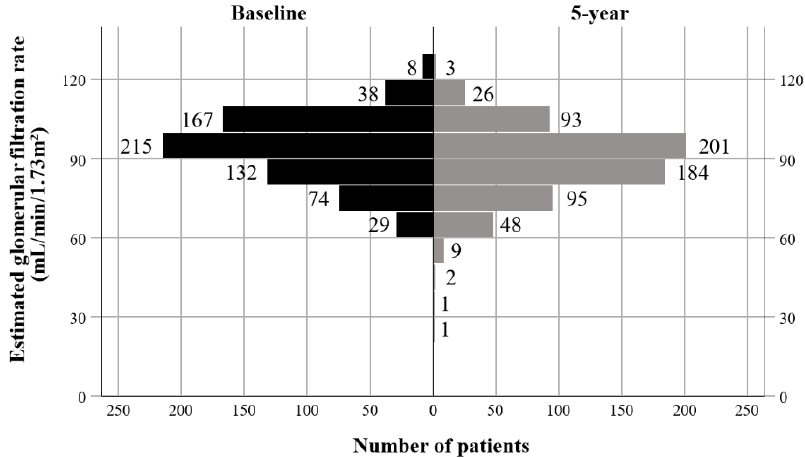
Figure 1. Histogram of baseline and five-year estimated glomerular filtration rates.